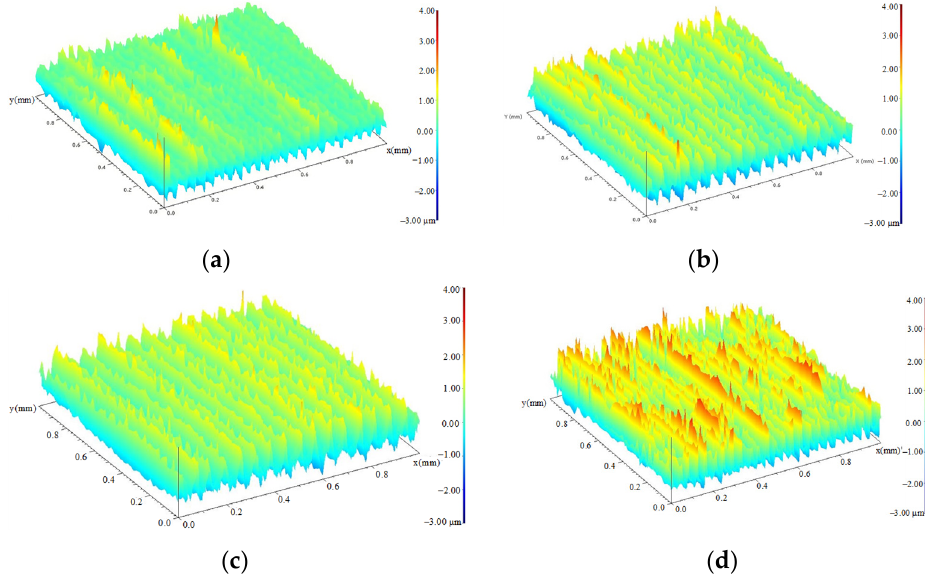
Figure 4. Surface topography of turned specimens during fatigue evolution. ( a ) 0 cycles; ( b ) 9.66 × 10 3 cycles; ( c ) 9.66 × 10 4 cycles; ( d ) 9.66 × 10 5 cycles.